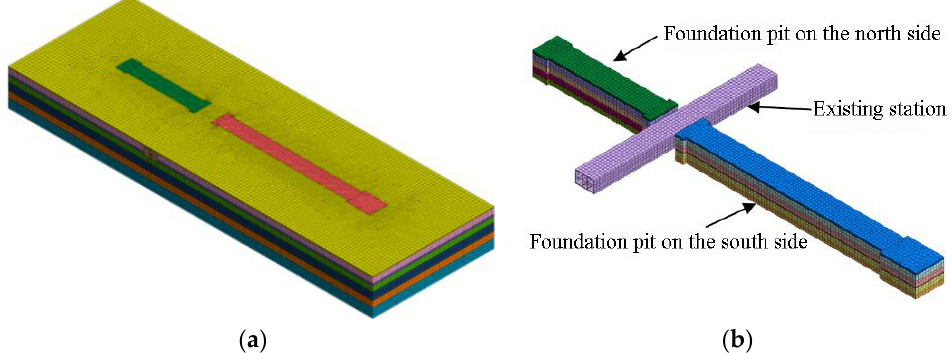
Figure 4. Model diagram of foundation pit excavation next to existing station: ( a ) Overall model diagram; ( b ) Foundation pit and station location.